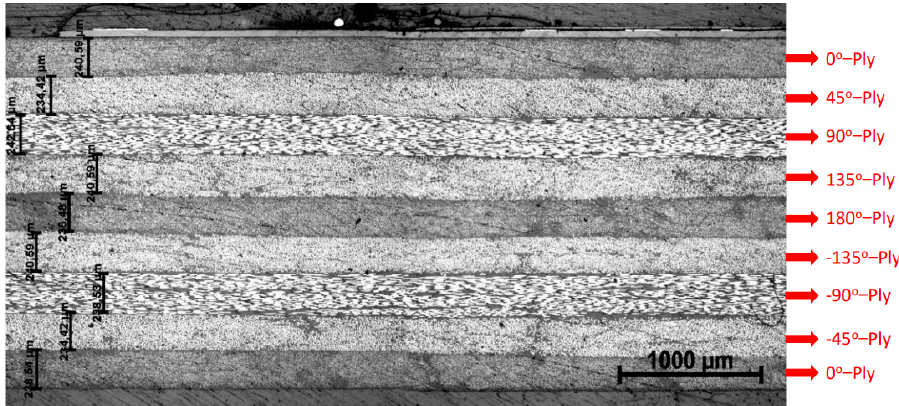
Figure 6. Cross ‐ sectional microstructure characterization of the multidirectional CFRP sample. Figure 6. Cross-sectional microstructure characterization of the multidirectional CFRP